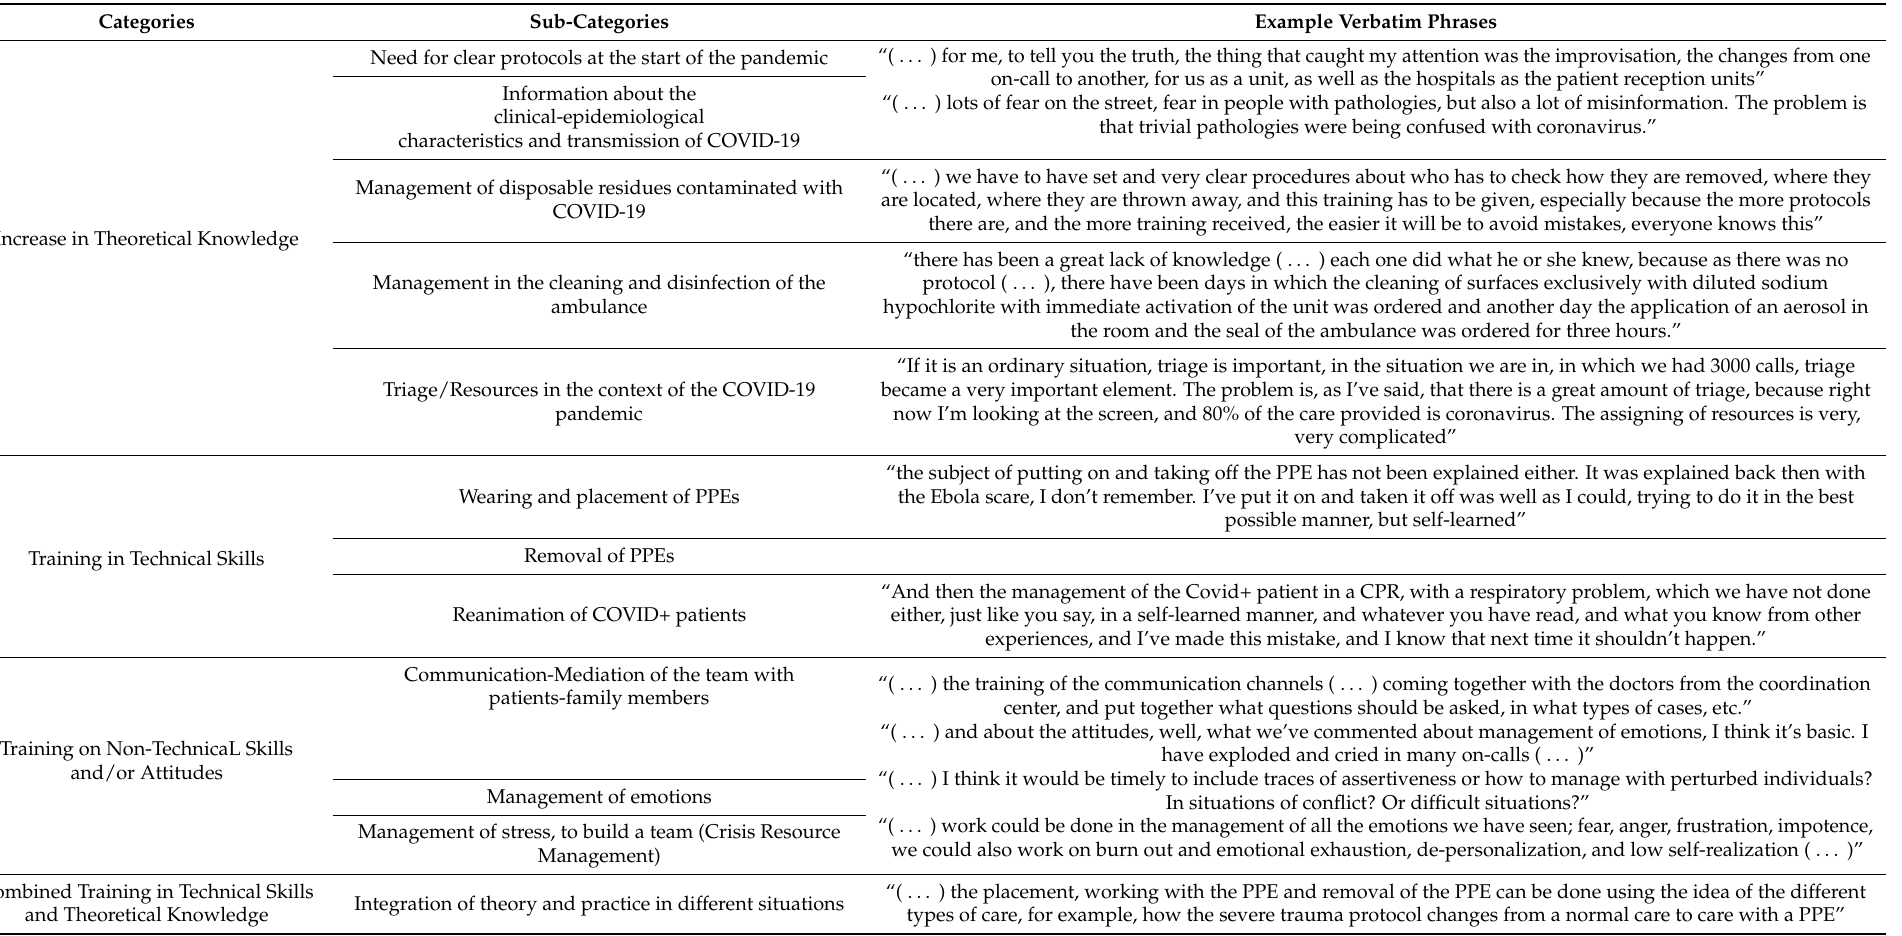
Table 4. Categories and sub-categories of the EMS focus